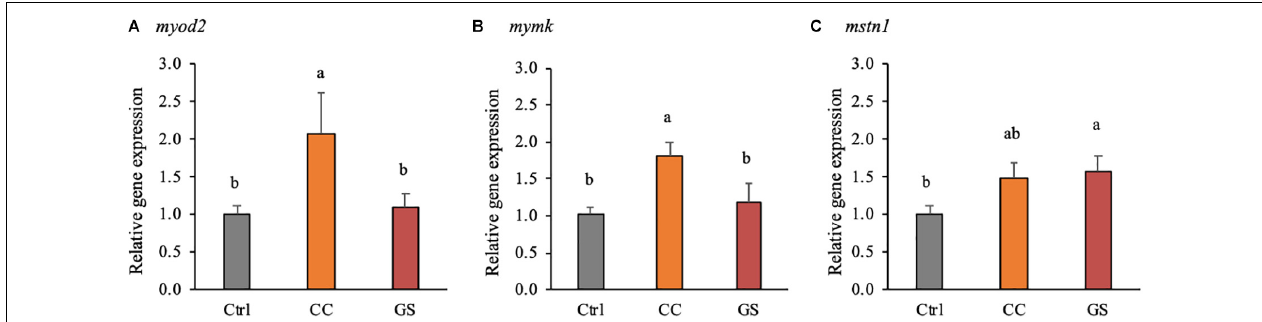
FIGURE 3 | Expression of genes encoding for muscle development and epigenetic regulation: myod2 (A) , mymk (B) , and mstn1 (C) , at 70 DAH ( n = 4). mRNA expression was normalized to transcript levels of ubq and rps4. Values are presented means ± SEM. Different superscript letters indicate significant differences ( P < 0.05, one-way ANOVA) between the dietary treatments (CTRL, CC, and GS).